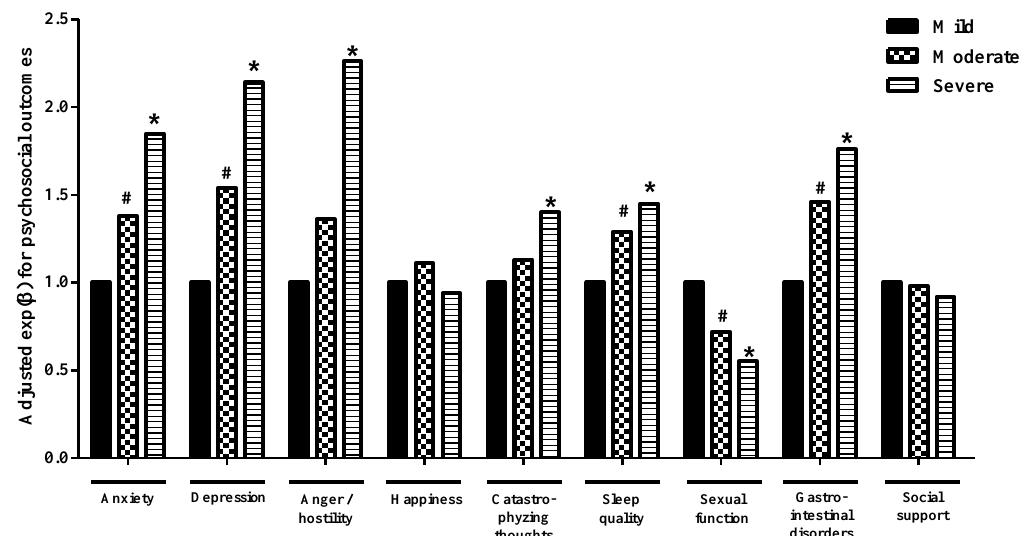
Figure 1. Influence of chronic fatigue on psychosocial status in Spanish women with endometriosis. Results from multivariate linear regression analyses adjusted for age (years), schooling, civil status, number of surgeries, type of diagnosis, time since diagnosis, number of children, premenstrual symptom severity and last week pelvic pain intensity. # p -value ≤ 0.05 between mild and moderate groups; * p -value ≤ 0.05 between mild and severe groups.